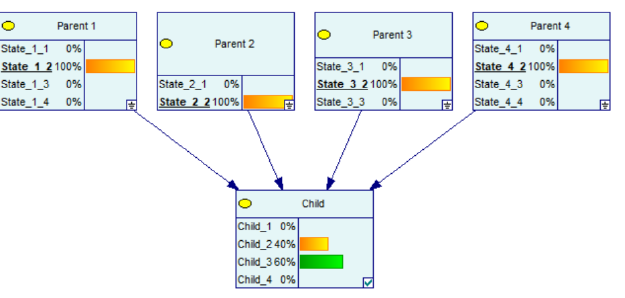
Figure 9. Weighted Diagonal: example to show the order of the parent’s states.